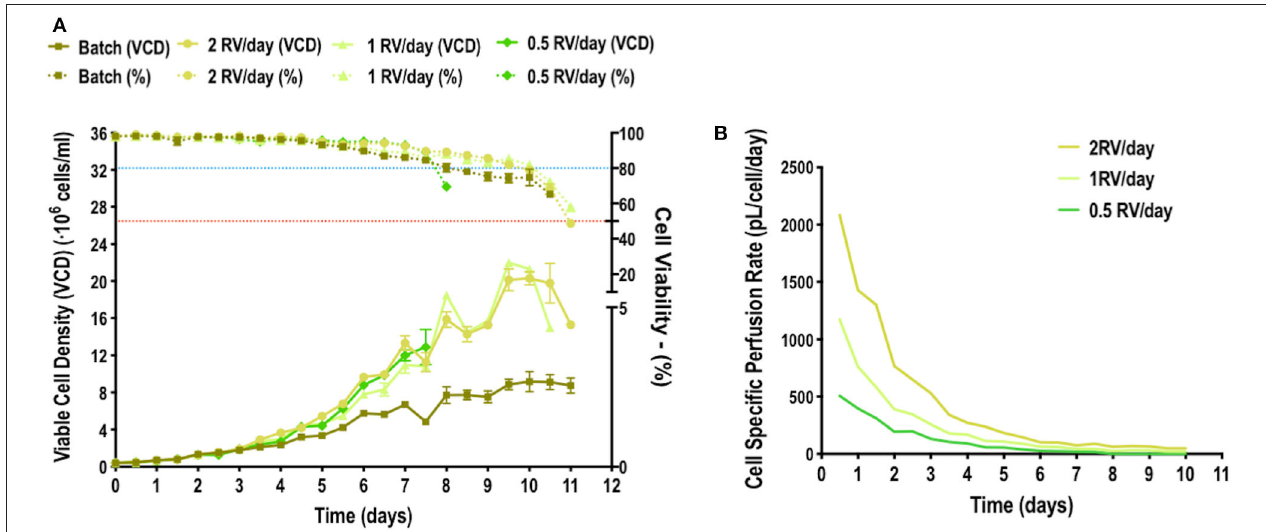
FIGURE 1 | Pseudoperfusion growth curves (A) HEK293 cell culture growth curves in shake flasks where media replacement was performed at a rate of 0.5, 1, or 2 reactor volume per day (RV/day) and a batch condition where no media replacement was carried out. Blue and red dotted lines represent 80 and 50% of cell viability, respectively. Experiment performed n = 3. (B) Representation of the cell specific perfusion rate (CSPR) from cell cultures with different rate of media replacement.